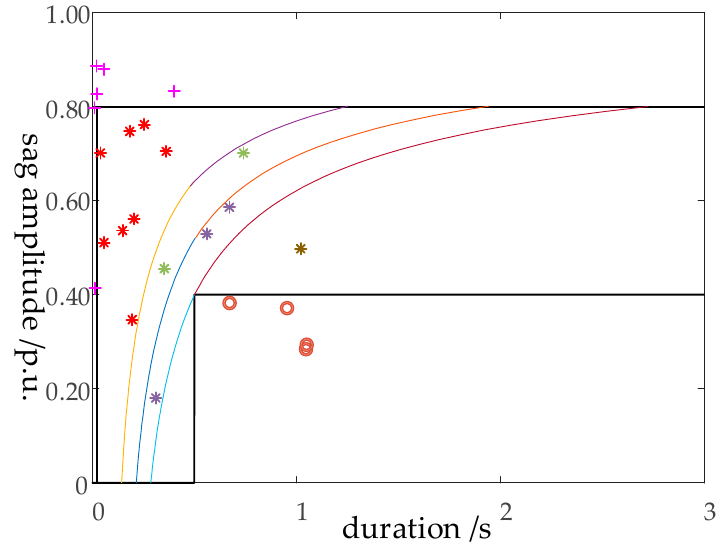
Figure 8. Distribution and severity levels of voltage sag events.